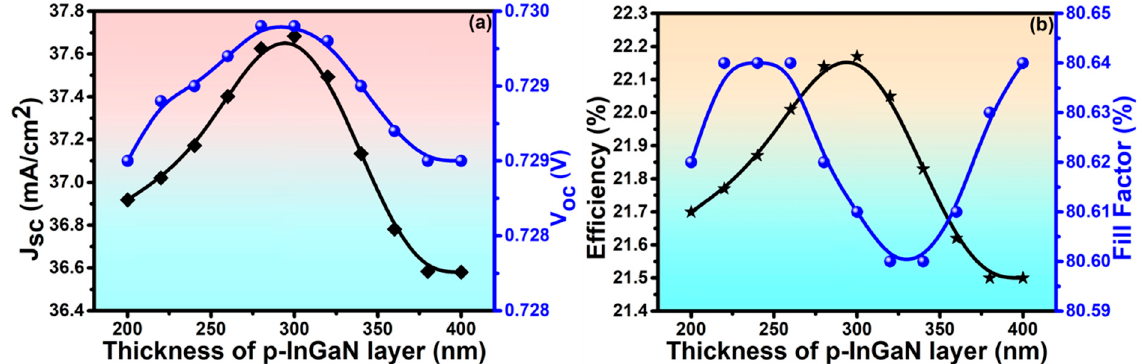
Figure 5. Impact of the thickness of the p ‐ InGaN region on ( a ) short ‐ circuit current density and open ‐ circuit voltage, and ( b ) efficiency and fill factor.